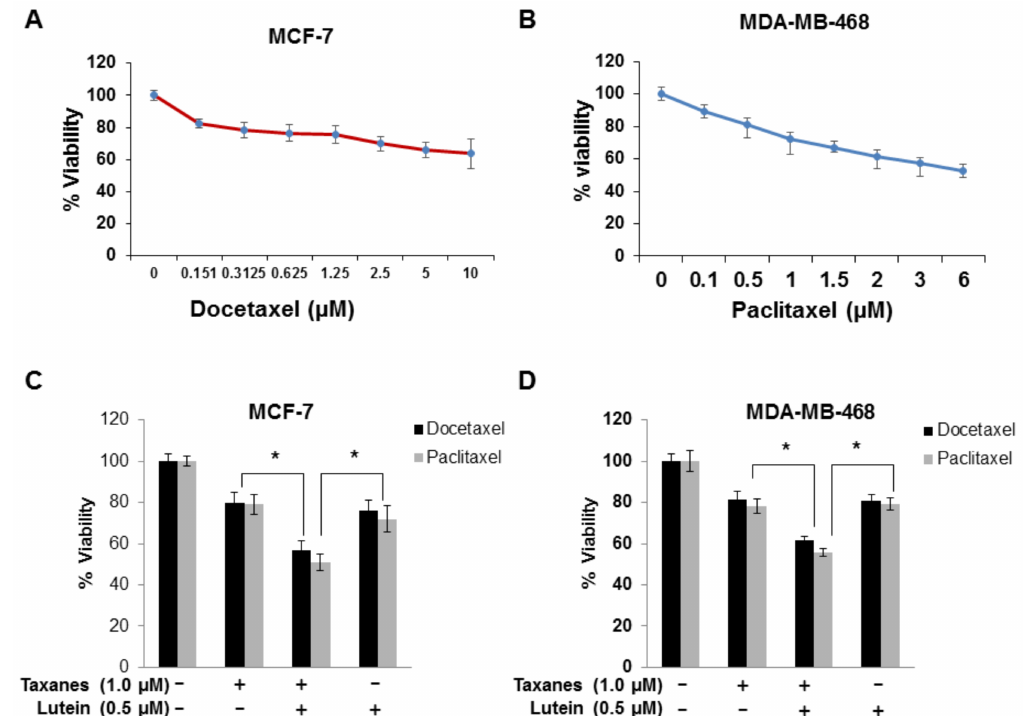
Figure 5. Enhanced effects of lutein and chemotherapeutic taxanes in human breast cancer cells. ( A ) MCF-7 cells were treated with docetaxel for 24 h in a dose-dependent manner and MTT assays were used to assess cytotoxic and growth effects of exposure to docetaxel. ( B ) MDA-MB-468 cells were treated with paclitaxel for 24 h in a dose-dependent manner, and cell viability was measured using MTT assays. The experiments were performed in triplicate. Data are presented as mean ± S.D and (1.0 µ M), lutein alone (0.5 µ M) and lutein in combination with a taxane. ( D ) MDA-MB-468 cells